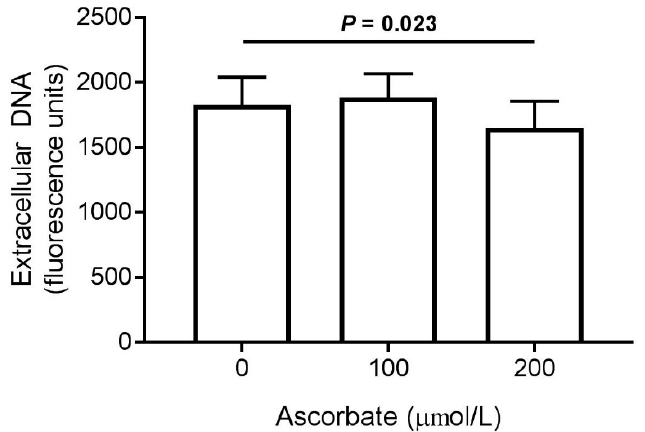
Figure 7. Effect of ascorbate on NET production by activated neutrophils. Cells were incubated with extracellular ascorbate (0, 100 or 200 µmol/L) and stimulated with PMA (2 μ g/mL) for 4 h. Extracellular DNA was stained with SytoxGreen™ and fluorescence measured as a marker of NET production. Data represent mean ± SEM, n = 5.